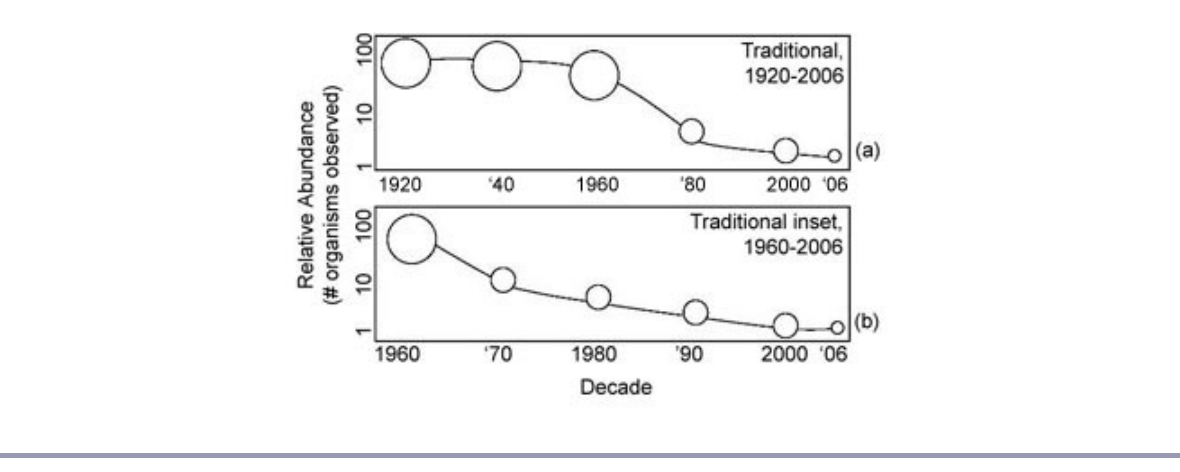
Fig. 1. Abundance and distribution of traditional species social-ecological guild. The abundance scale on the y-axis of the bubble diagram refers to real numbers, i.e., 1 is an observation of single fishes, 10 is of 10 or 10’s of fishes, 100 is of 100 or 100’s of fishes, and so on. Relative changes to distribution are represented by different sized bubbles. Thus, a constant size of bubble indicates no evidence of change in distribution (sites inhabited, or range within the habitat) from one year to the next, whereas expanded or contracted bubbles illustrate changes in distribution. This system of representation is used in all subsequent bubble